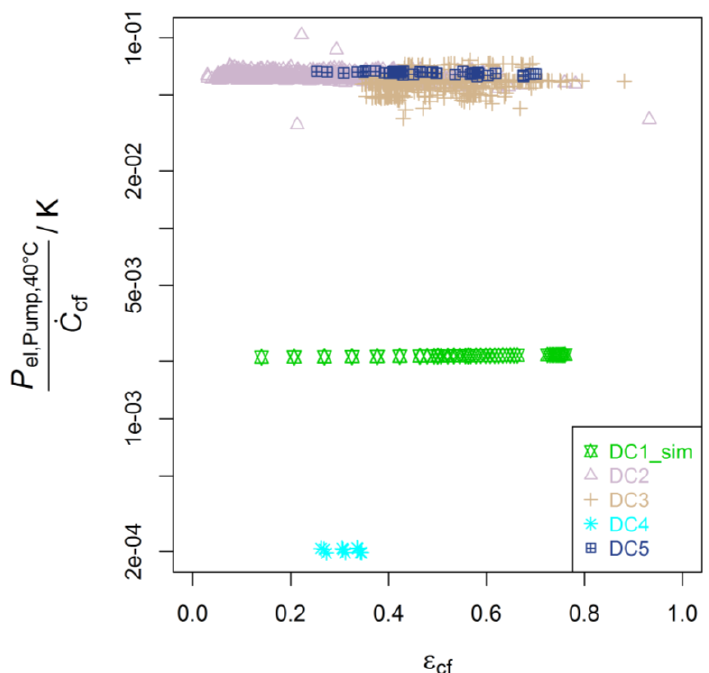
) normalized with cooling fluid el,Pump,40°C ) for simulated and monitored dry cf